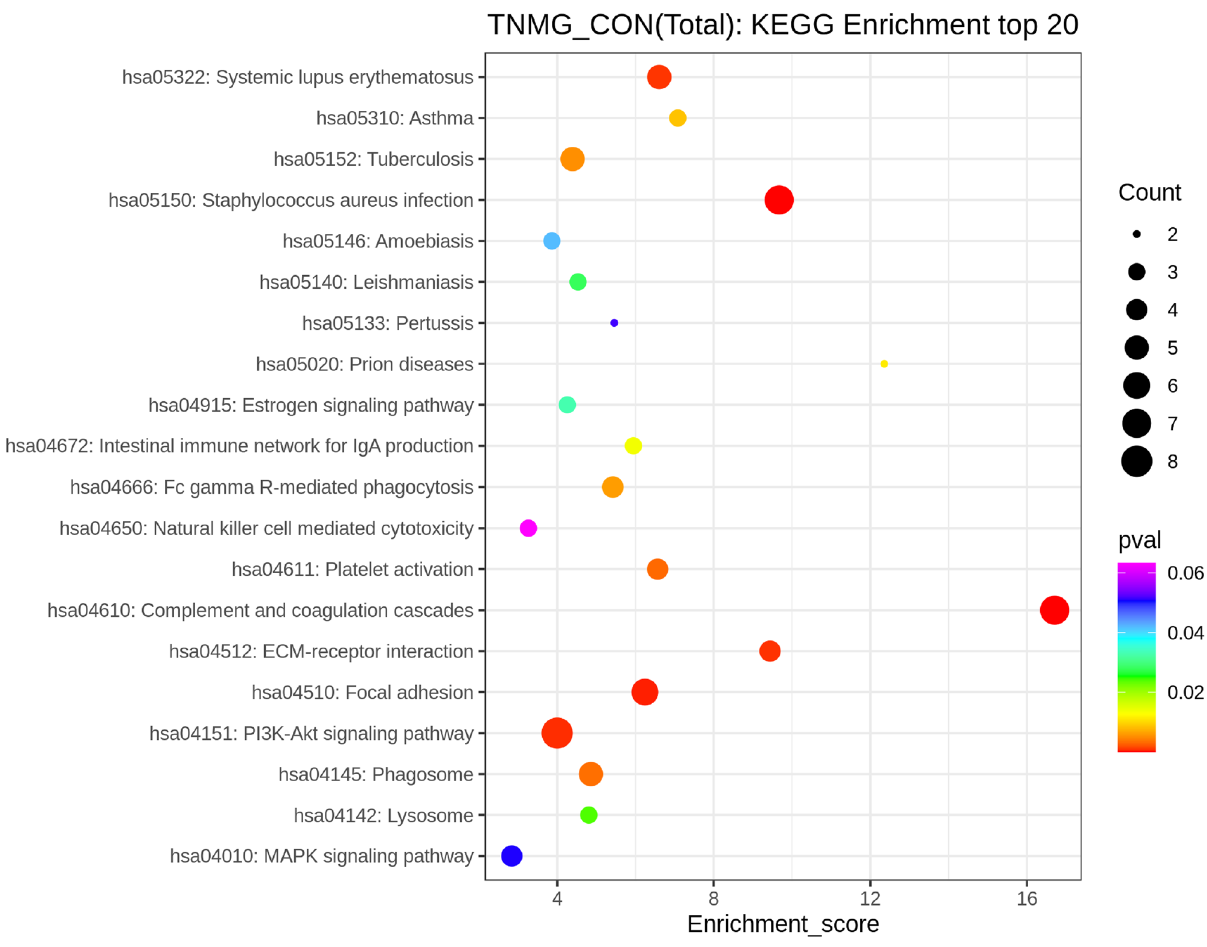
Figure 6. KEGG annotation and enrichment analysis. In the figure, the x-axis Enrichment score is the enrichment score and the y-axis is the pathway information of top20. The larger the bubble, the more the number of differential proteins, the color of the bubble changed from red–green–blue-purple, and the smaller the enrichment p value was, the greater the significance